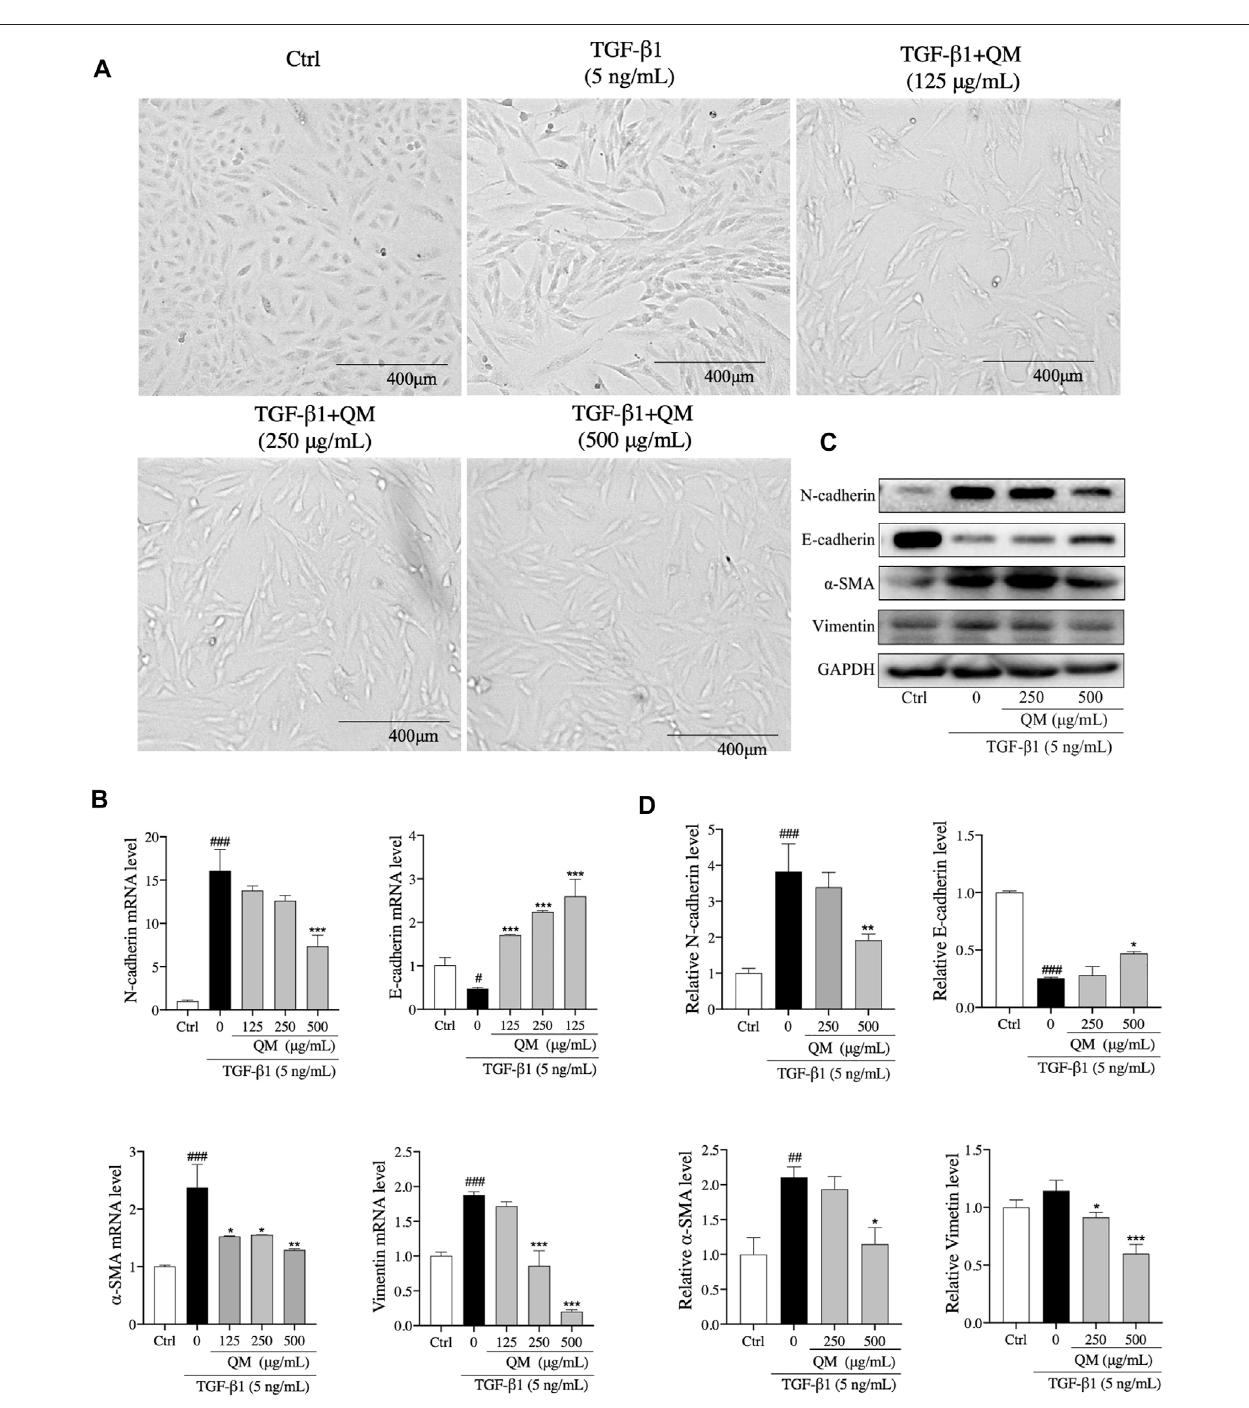
FIGURE 5 | QM-attenuated TGF- β 1 – induced EMT in A549 cells. (A) Representative light microscopic images of A549 cells treated with TGF- β 1 and/or QM (125, 250, or 500 μ g/ml). (B) After incubation with QM and TGF- β 1 for 72 h, the mRNA levels of N-cadherin, E-cadherin, α -SMA, and vimentin in A549 cells were determined by qPCR analysis. GAPDH was used for normalization. (C,D) After treatment for 72 h, the protein levels of N-cadherin, E-cadherin, vimentin, and α -SMA in A549 cells fromthecontrol,TGF- β 1,andTGF- β 1+QMgroupsweredeterminedbyWesternblotanalysis.GAPDHwasusedastheloadingcontrol.Therelativelevelsofthese proteins were calculated based ongray values from three independent experiments and normalized with GAPDH. # p < 0.05, ## p < 0.01, ### p < 0.001 versusthe control group; * p < 0.05, ** p < 0.01, and *** p < 0.001 versus the model group (TGF- β 1, 5 ng/ml).